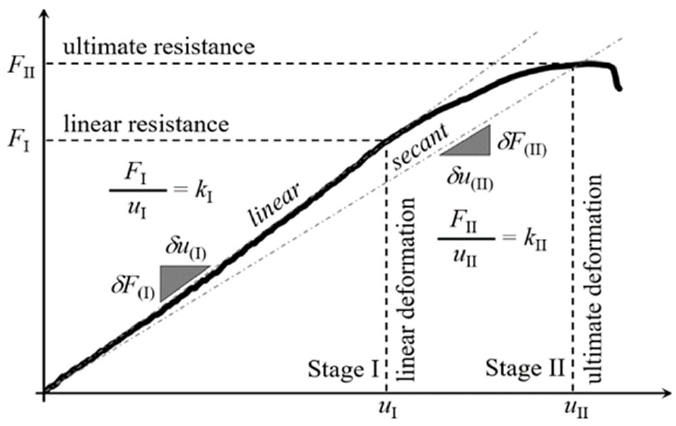
Figure 5. Connections’ parameters.